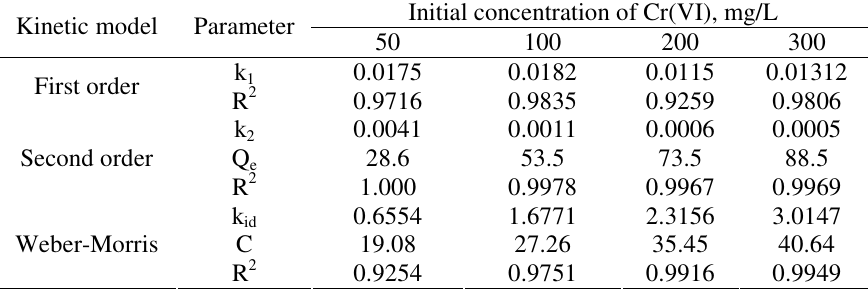
Figure 5 . Pseudo first order plots for adsorption of Cr(VI) on trametes versicolor Table 1. Values of the parameters of kinetic